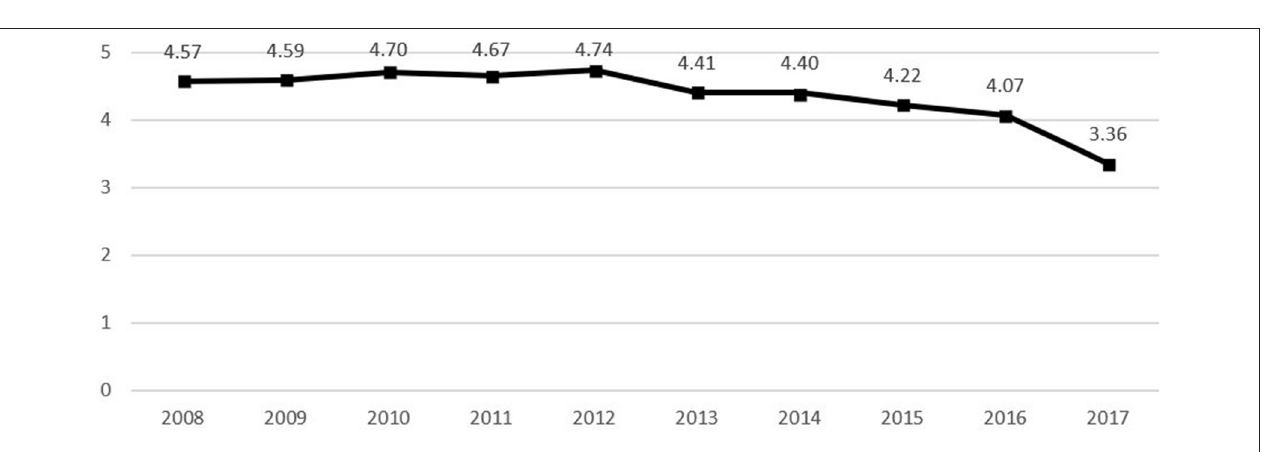
FIGURE 2 | TB deaths per 100,000 population by